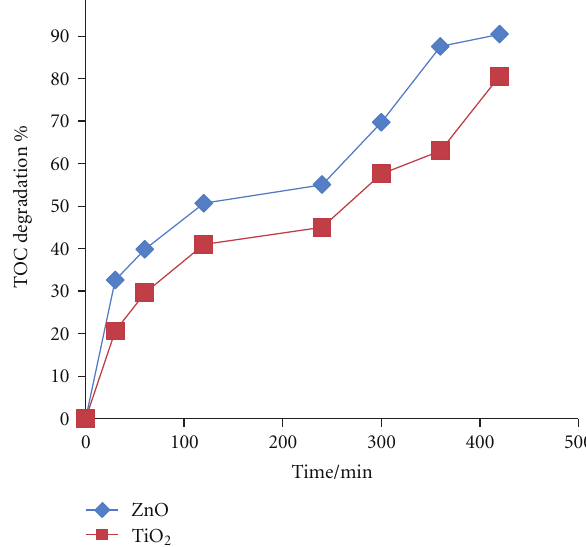
Figure 11: Mineralization of